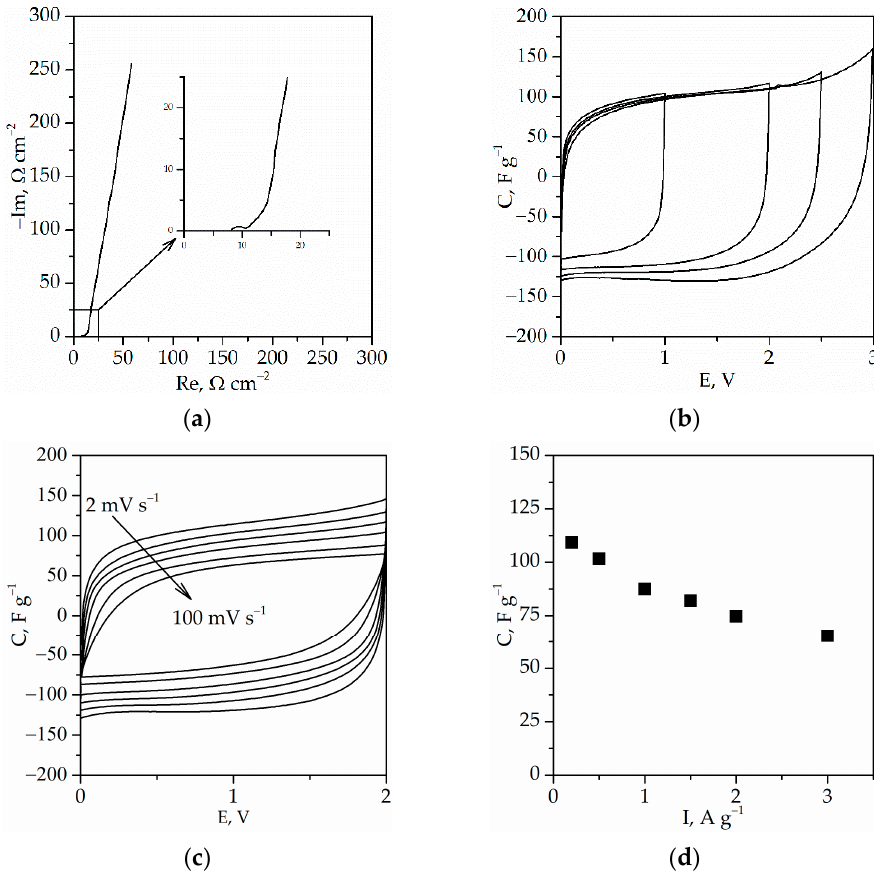
Figure 11. ( a ) Nyquist plot of EDLC; ( b ) cyclic voltammograms up to various values of maximum potential, scan rates 5 mV ∙ s − 1 ; ( c ) cyclic voltammograms at scan rates from 2 to 100 mV ∙ s − 1 ; ( d ) discharge capacitance vs. current of EDLC. Capacitance and current expressed per AC mass in one electrode.